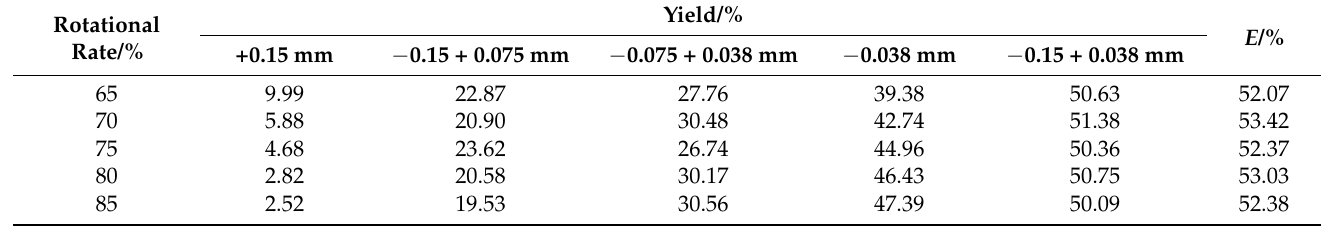
Table 11. Particle size composition of grinding products at different rotational rates.